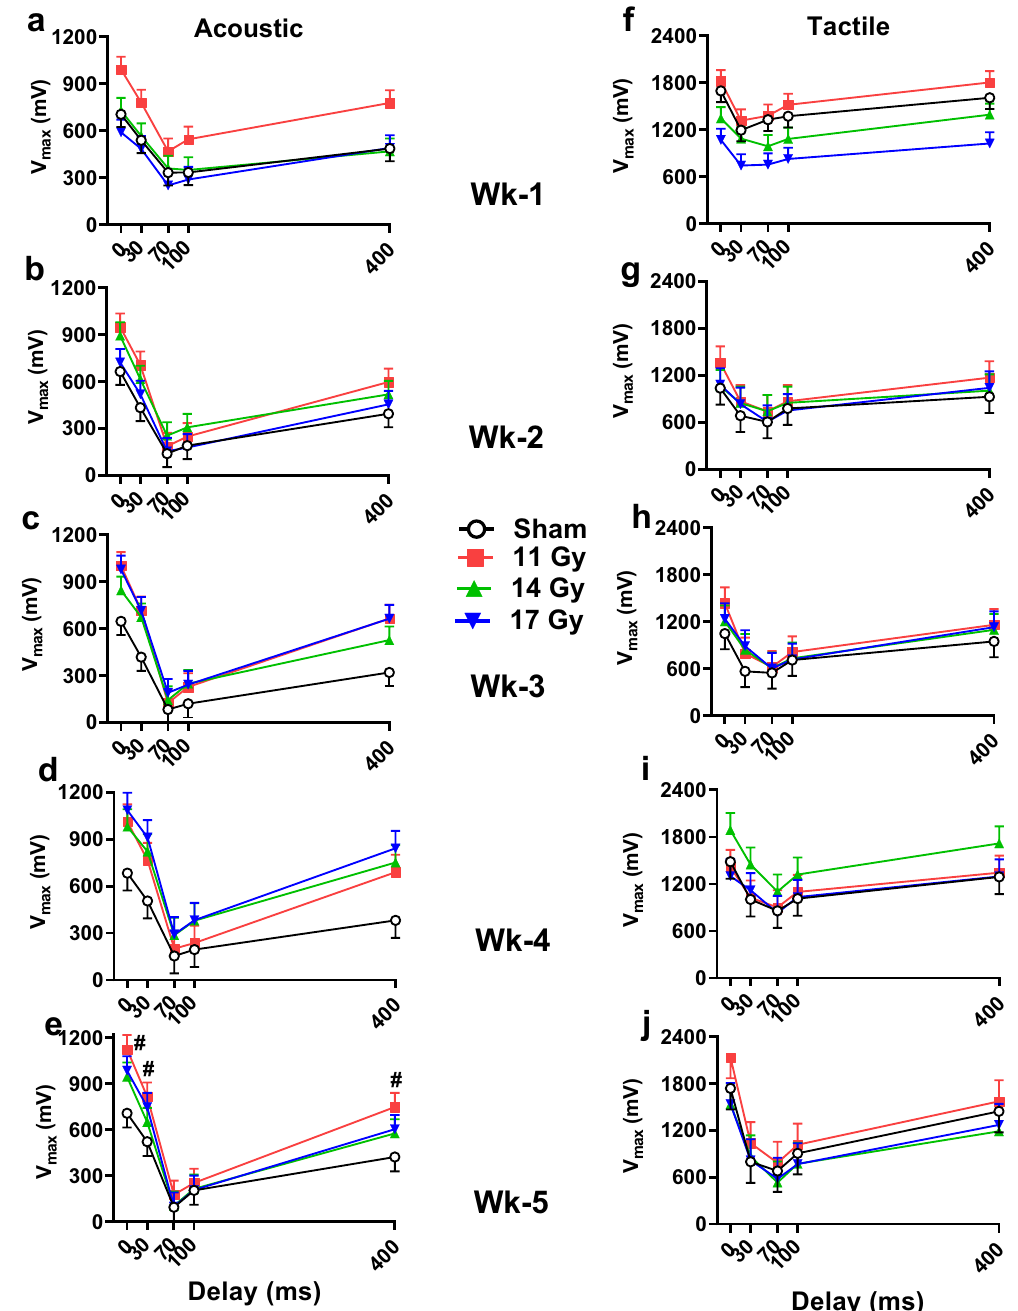
Figure 4. Weekly light PPI of ASR (intervals of 30, 70, 100, and 400 ms) ( a–e ) and light PPI of TSR ( f-j ) after proton exposure. The 11 Gy group had increased ASR at weeks 1, 3, and 5 ( a,c,e : p < 0.05) and the 17 Gy group had increased ASR at weeks 3 and 4 ( c,d : p < 0.05), regardless of prepulse compared with the controls. At week 5 for ASR there was an interaction, # p < 0.05 compared with control. The 11 and 17 Gy groups had increased ASR when the response was unmodified. The 11 Gy rats had increased ASR at 30 and 400 ms. For TSR the only effect was at week 1 ( f ) when the 17 Gy rats had smaller responses compared with controls (main effects have no significance indicators on the figure). N = 10/group/time